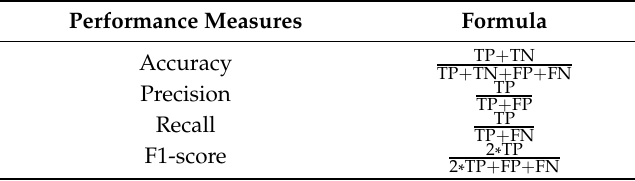
Table 5. Performance of classification model